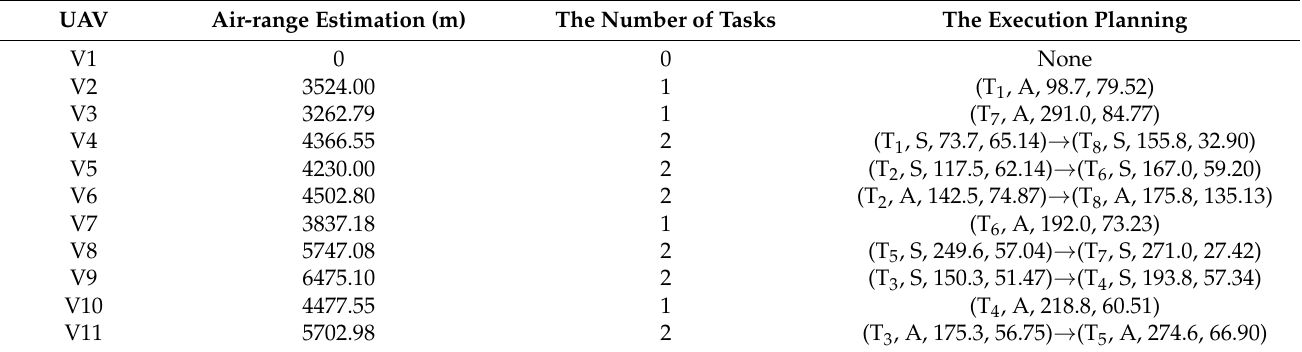
Table 8. The task assignment of the UAV swarm.